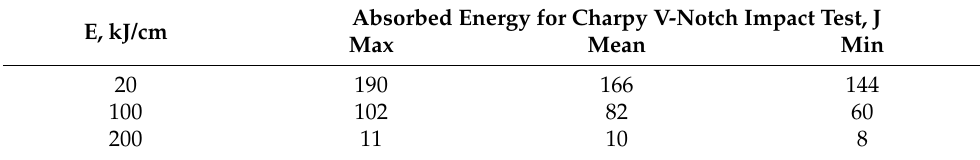
Table 6. Measured impact toughness results of the CGHAZ containing 0.14% Nb at − 20 ◦ C. E,